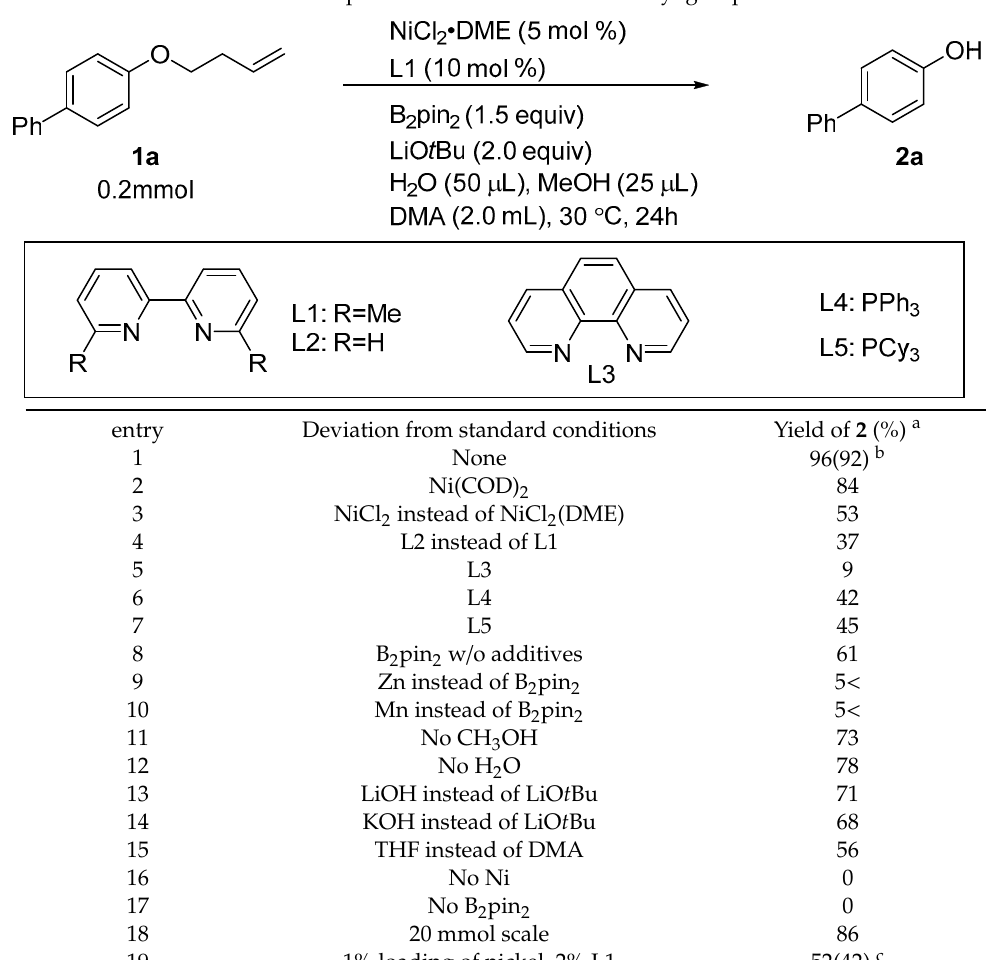
Table 1. Optimization of removal homoallyl group.